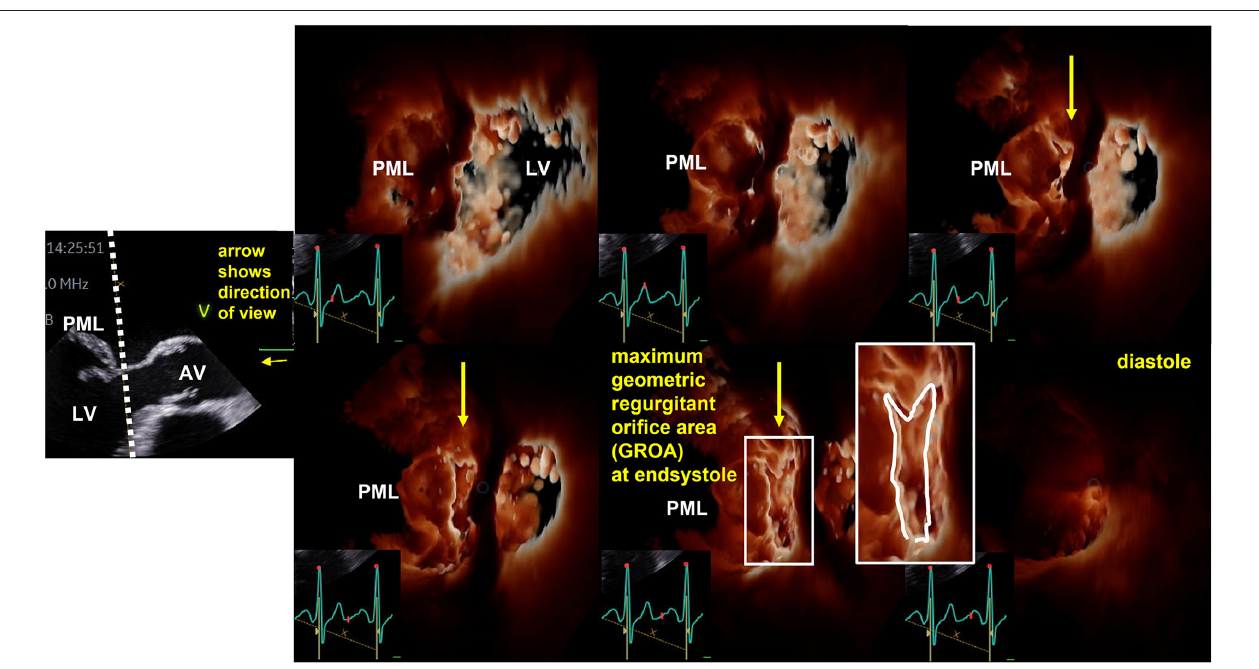
FIGURE 4 | Illustration of the dynamics of geometric regurgitant orifice area (GROA) in a patient with primary mitral regurgitation by 3D transesophageal echocardiography (TEE). On the left side the sectional plane of a TEE long axis view is shown. The dotted line represents the cutting plane of the en-face view to the GROA. The direction of view is illustrated by the yellow arrow. AV, aortic valve; LV, left ventricle; PML, posterior mitral leaflef. Right to this 2D image six consecutive 3D-en-face views to the GROA are presented illustrating the maximum GROA at end